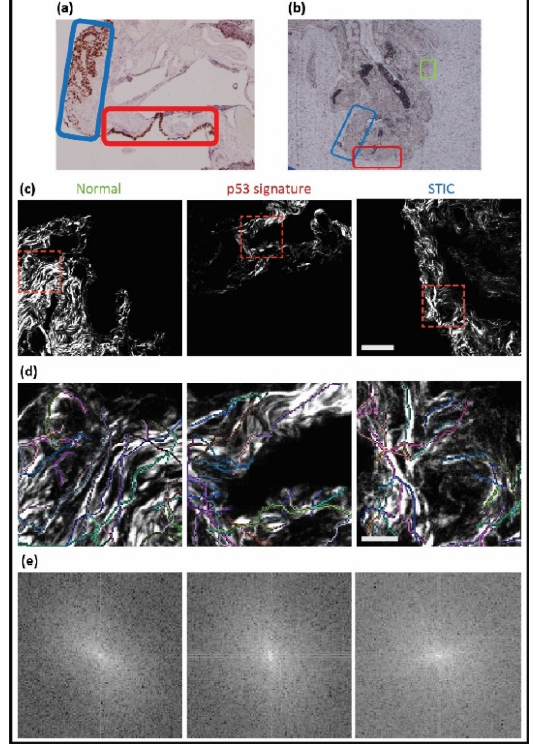
Figure 3. Workflow for identifying p53 and STIC precursors. A pathologist defined these tissues in mutant p53 stained images ( a , 4×), where green, red, and blue correspond to normal regions, p53, and STIC, respectively. The correlated unstained regions ( b , 4×) were identified and then used for SHG imaging, where the corresponding images are shown in ( c ) (field size = 180 × 180 microns). ( d , e ) CT-FIRE overlays and 2D-FFT power spectra of the cropped SHG images (red-dashed boxes) are shown.